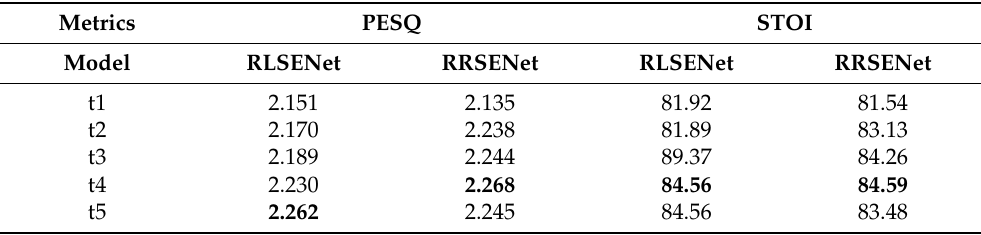
Table 6. Experimental results of RLSENet and RRSENet under unseen noise conditions. BOLD indicates the best result for each case.